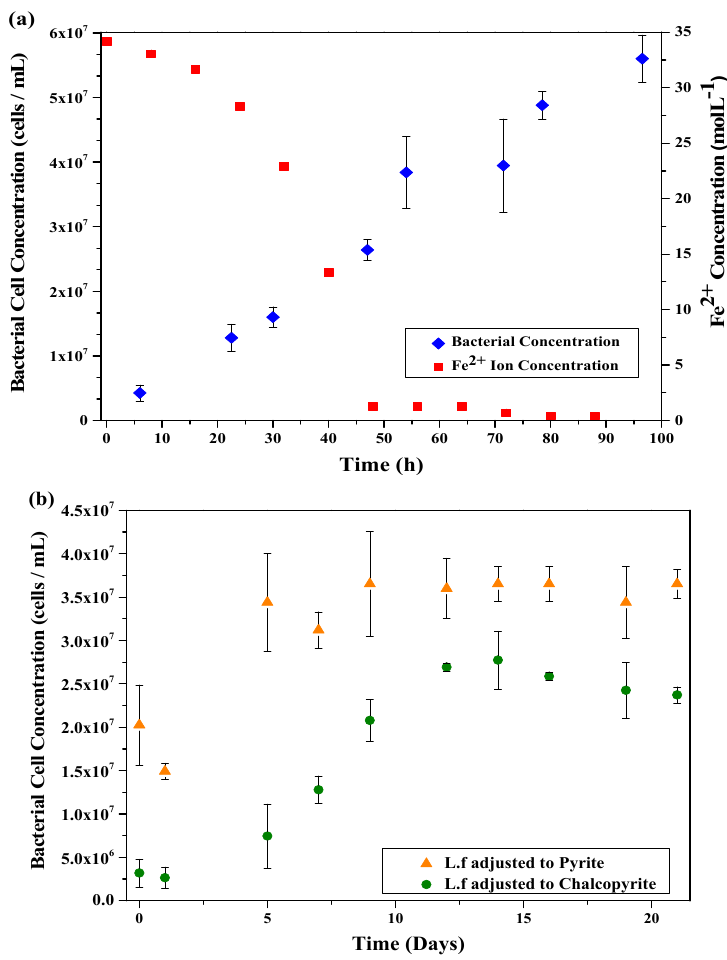
Figure 1. Bacterial growth curves of ( a ) L.f grown on HH media with iron (II) sulfate and ( b ) L.f grown on Py and Cp.